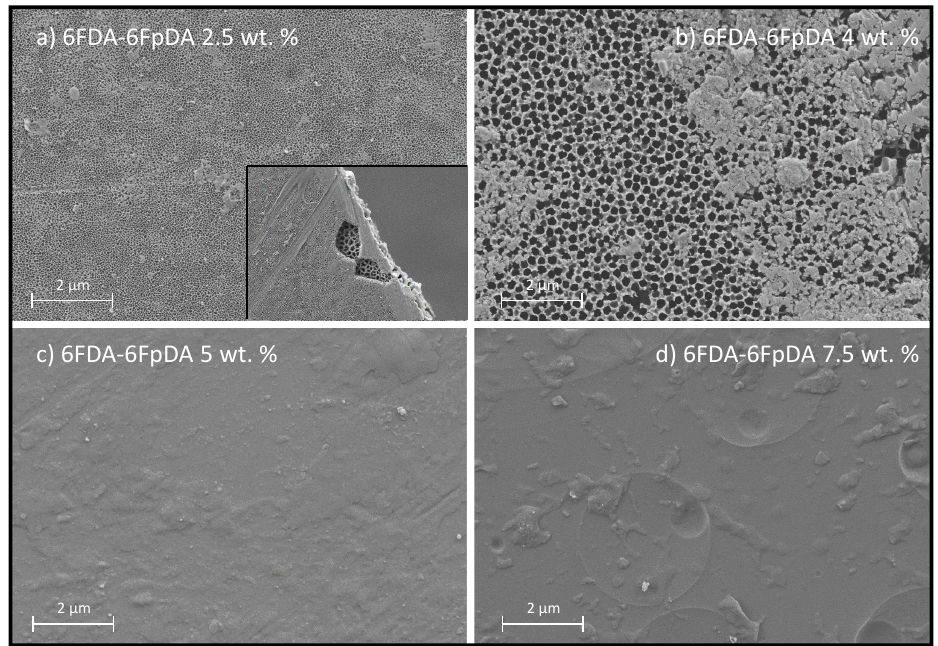
Figure 8. SEM micrographs of 6FDA-6FpDA dip-coated in alumina support with different solution concentrations: C < C* ( a ), C ∼ C*( b ), and C > C* ( c and d ). Inset image in ( a ) corresponds to a